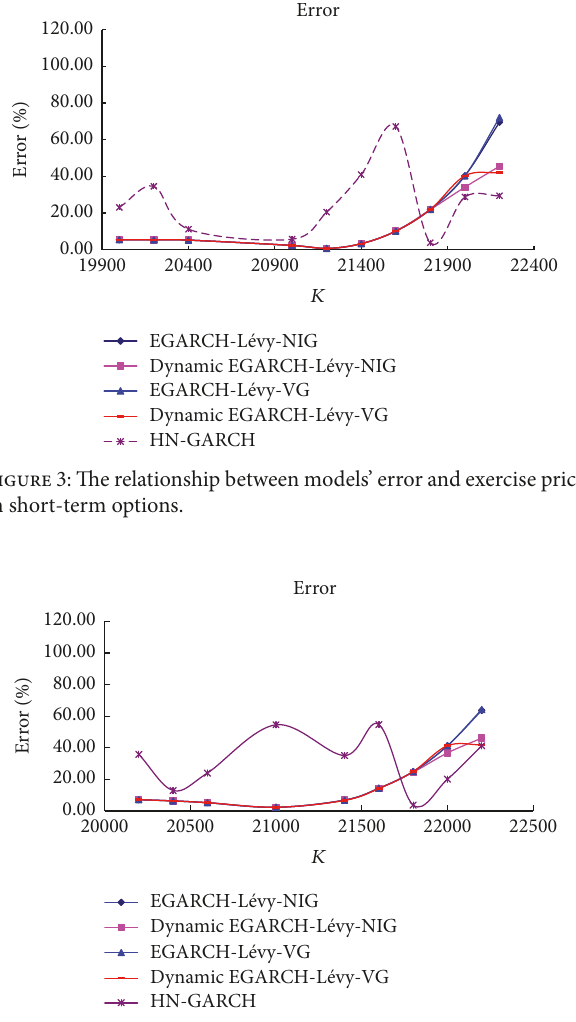
Figure 4: The relationship between models’ error and exercise price in long-term